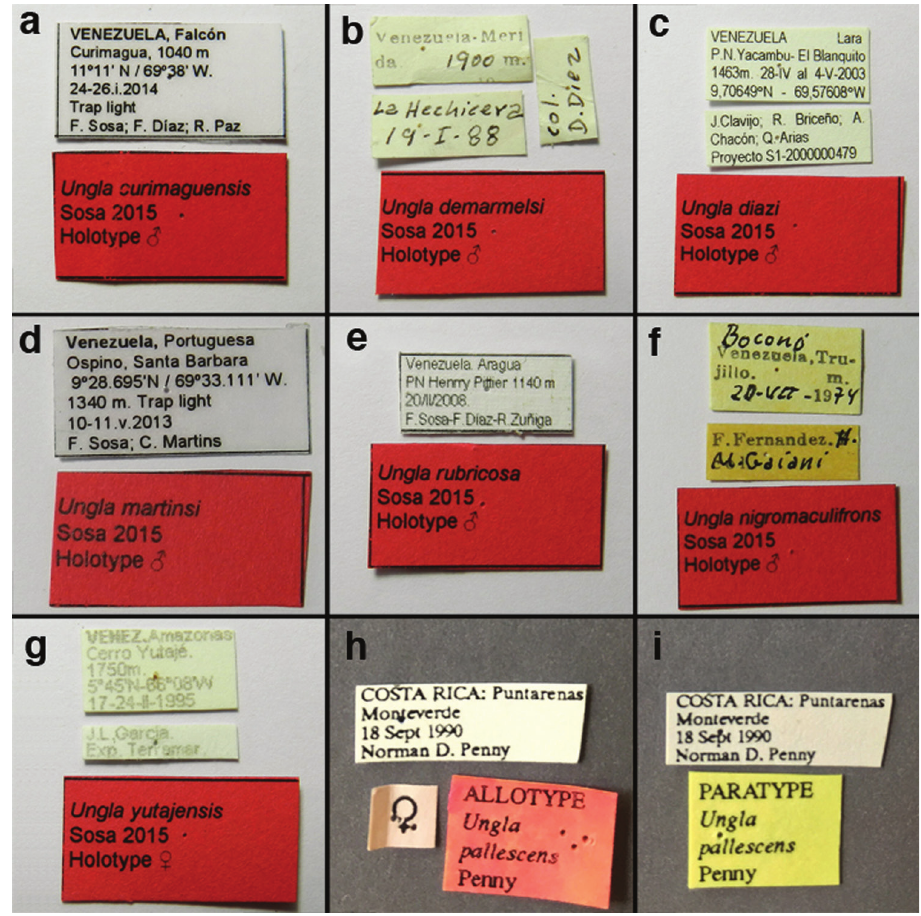
Figure 143. Type labels from Ungla species described in recent years before this study, a–g Sosa (2015) h, i Penny